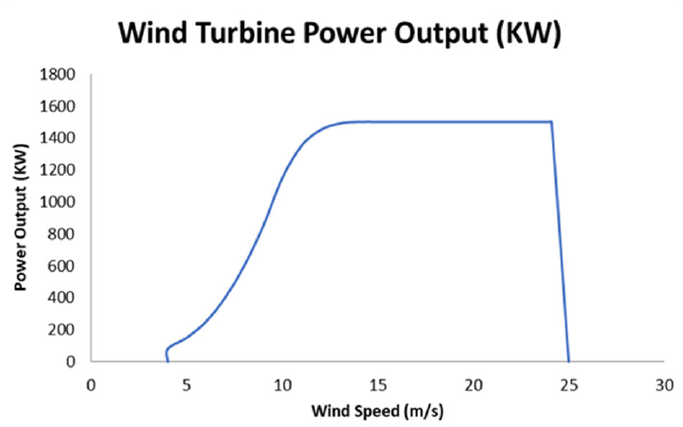
Figure 6. The wind turbine’s output power.